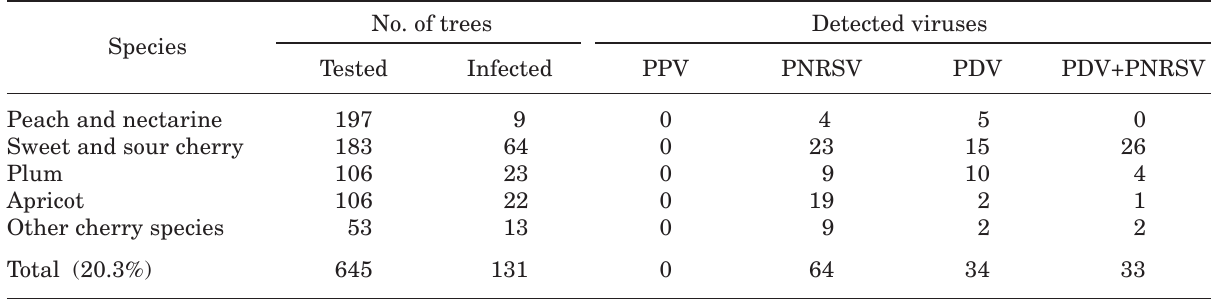
Table 1. Viruses detected by ELISA in Clonal Genebank Prunus accessions (Harrow, Canada).